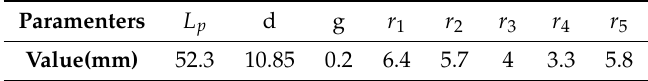
Table 1. The parameters of the BDS antenna element.